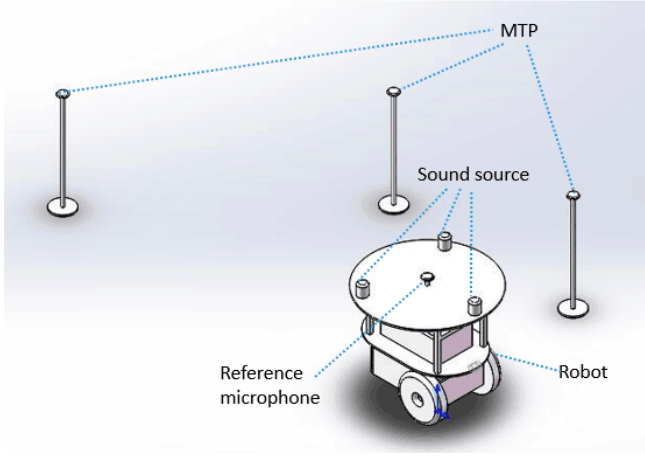
Figure 1. Reference frame of the system and the main components.